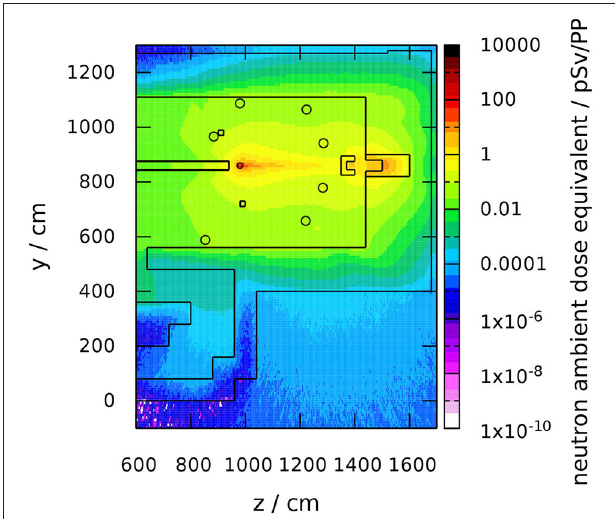
FIGURE 4 | Simulated neutron ambient dose equivalent distribution, normalized per primary particle, in the experimental room during the IBER 17 experiment.